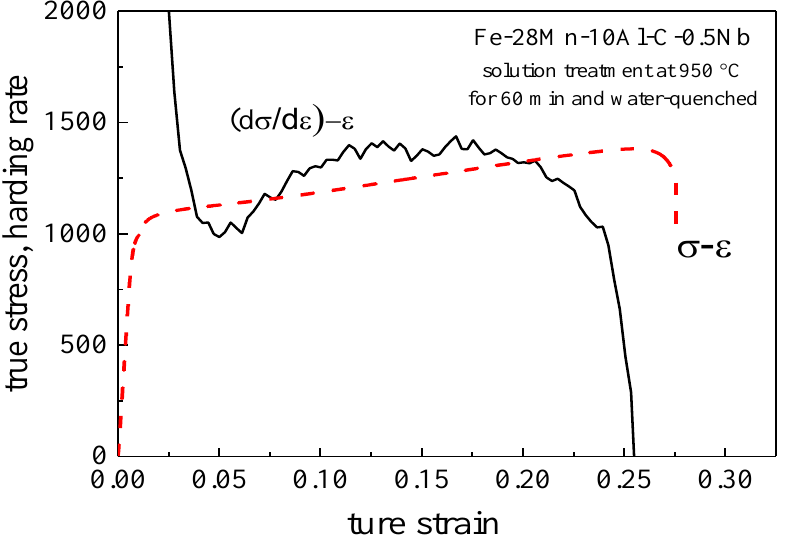
Figure 9. True stress-strain curves of Fe–28Mn–10Al–C–0.5Nb low-density steels and the corresponding strain hardening rate as a function of true strain.